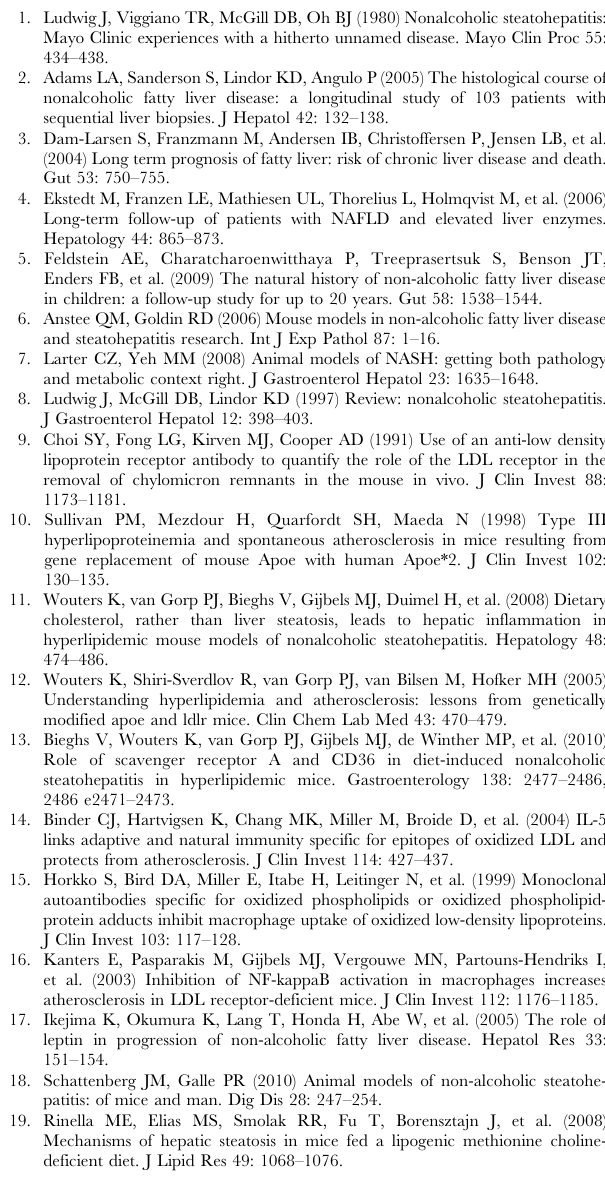
different from chow group. * and *** indicate p , 0.05 and 0.001, respectively. (TIF) Figure S6 Antibodies against oxidized LDL in plasma. (A) IgM auto-antibody titers to MDA-LDL and CuOx-LDL. (B) IgG auto-antibody titers to MDA-LDL and CuOx-LDL. * Signifi- cantly different from chow group. *, ** and *** indicate p , 0.05, 0.01 and 0.001, respectively. (TIF) Conceived and designed the experiments: VB PVG KW MH RS-S. Performed the experiments: VB PVG KW RS-S. Analyzed the data: